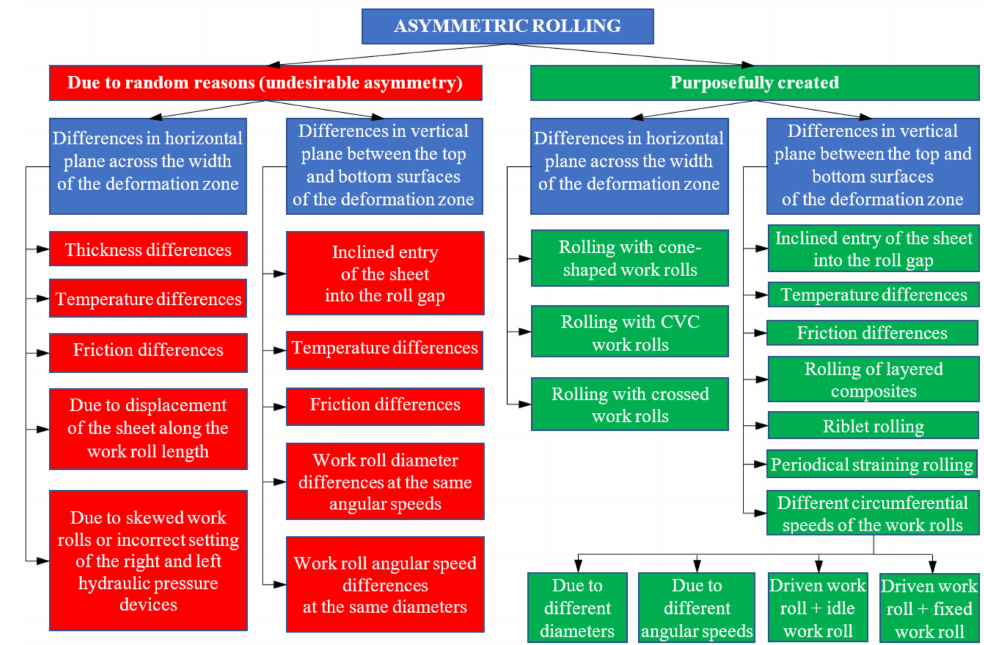
Figure 2. Classification of asymmetric rolling